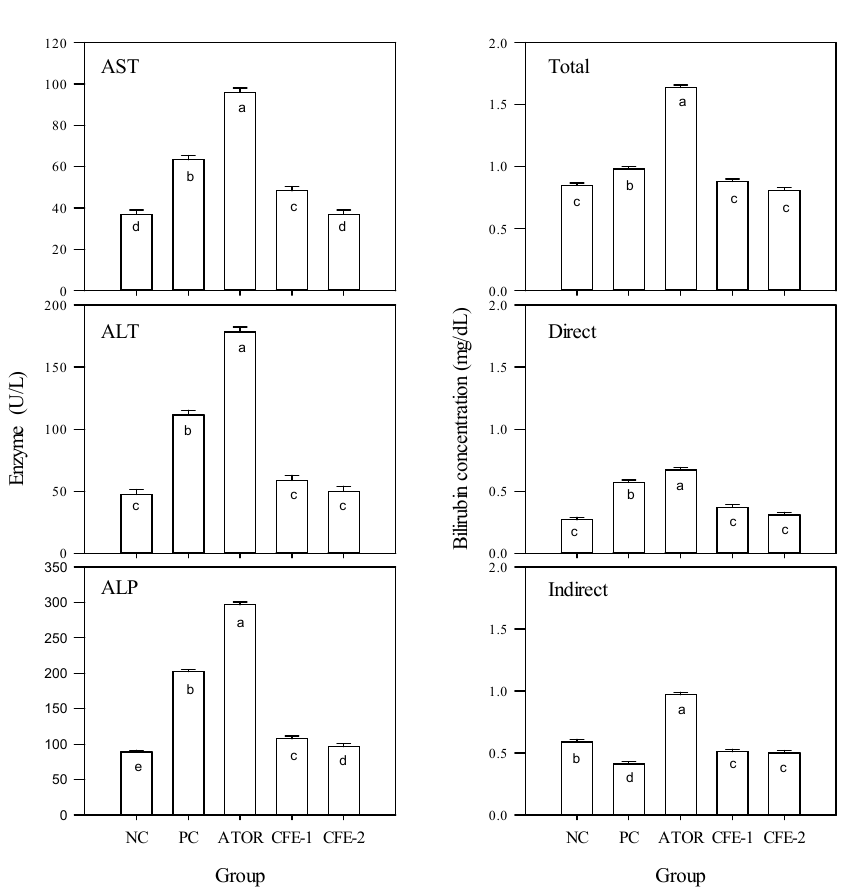
Figure 4. Aspartate aminotransferase (AST), alanine aminotransferase (ALT), alkaline phosphatase (ALP), and bilirubin (total, direct and indirect) in the serum of male Albino rats in 5 experimental groups during the 9-week study period. Group 1 received a normal diet (Negative control: NC). Groups 2–5 received a high-fat diet, where group 2 did not receive any further treatment (Positive control: PC). Group 3 was treated with atorvastatin (10 mg kg − 1 ), while groups 4 and 5 were treated with Lactobacillus paracasei postbiotic (CFE-1 and CFE-2; at 100 and 200 mg kg − 1 , respectively). Values are presented as mean ± SD ( n = 8). Mean values within the same histogram with different superscripts letters are significantly different ( p < 0.05). Forty animals were divided into five groups (8 animals each). Postbiotic is the cell-free extract (CFE).